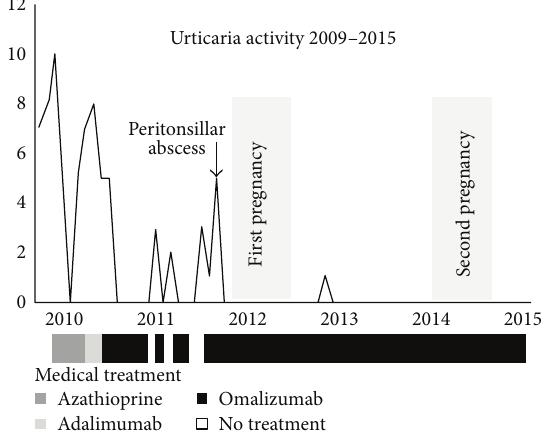
Figure 1: Urticaria activity from 2009 to 2015. Note: as no validated scoring system of urticaria activity was used during the course of treatment, the urticaria activity was scored on the basis of the severity of symptoms of remission or relapse described in the medical journal of the patient. The activity ( 𝑦 -axis) is scored from 0 (no urticarial activity) to 10 (most severe urticarial activity) depending on the description in the patient record. 𝑥 -axis denotes course of treatment with graphical representation of periods with medical